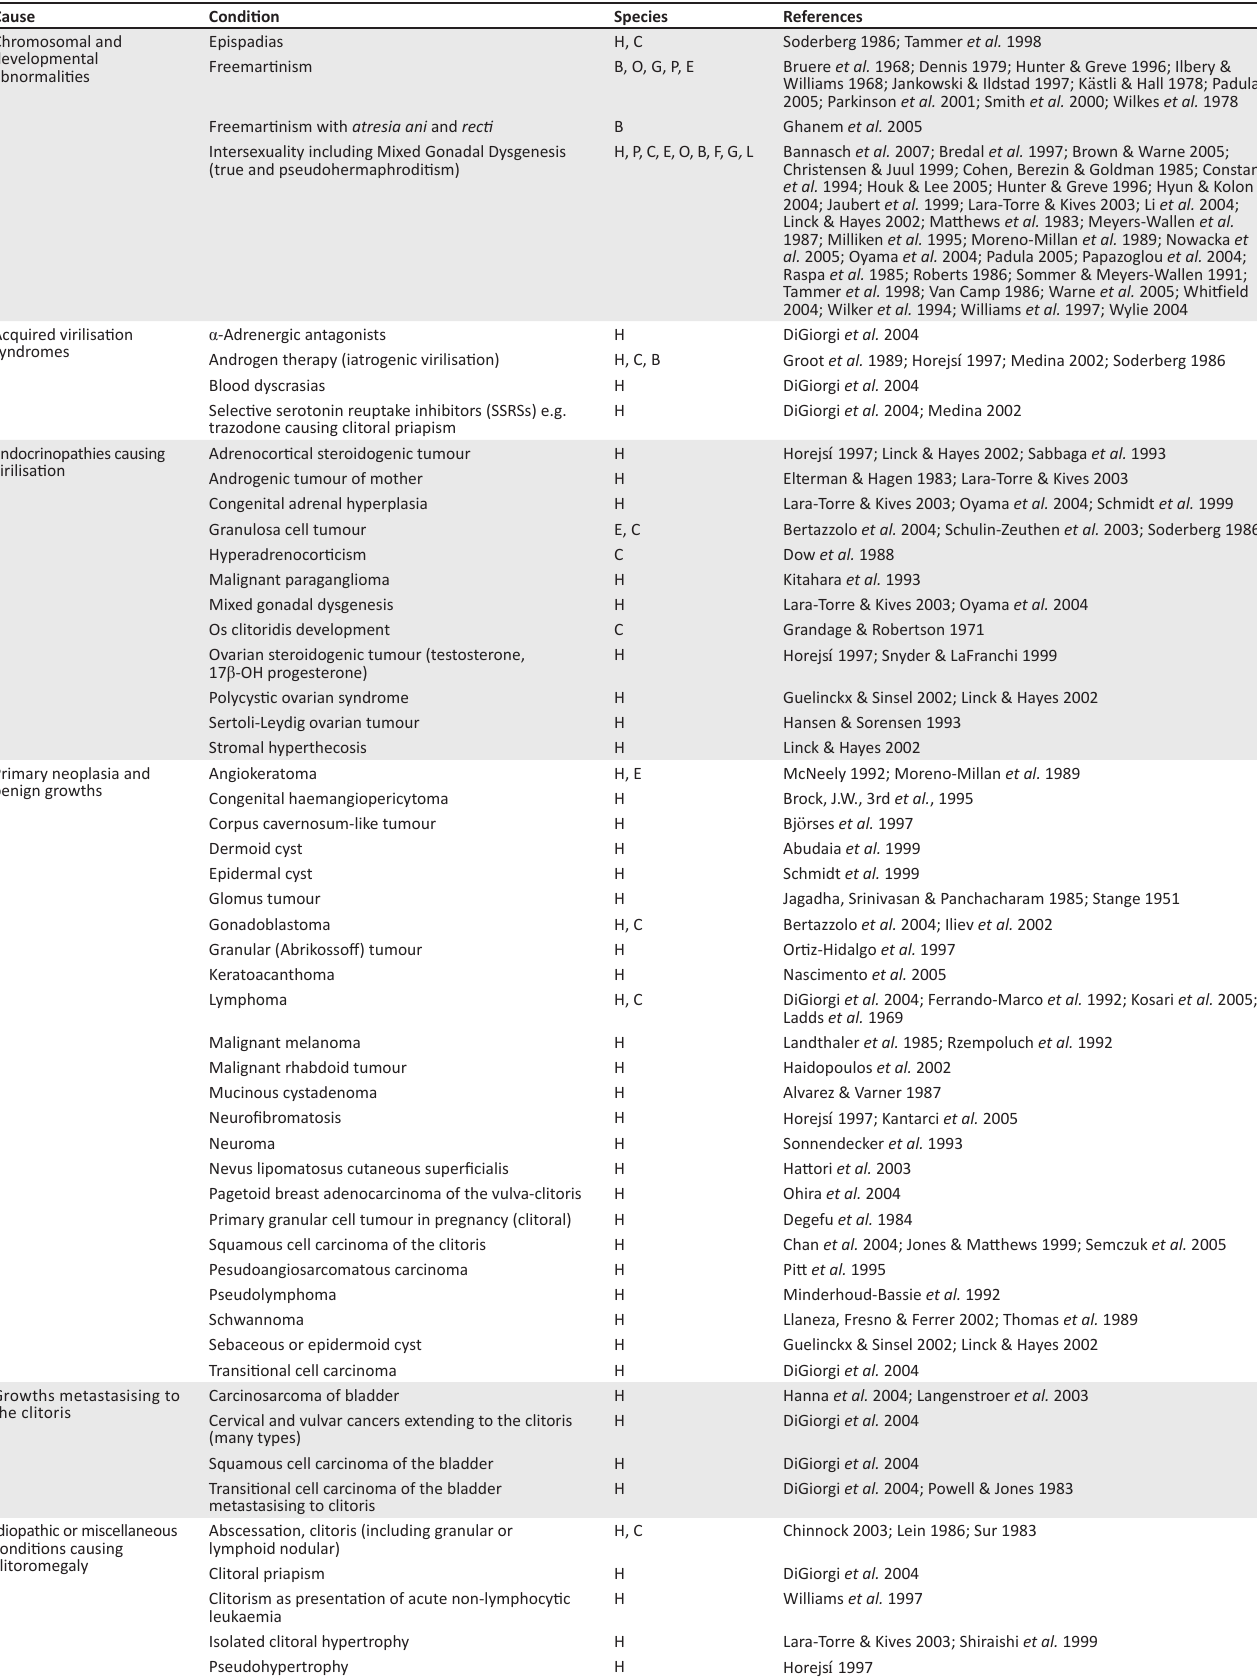
TABLE 3: Reported causes of clitoromegaly in the veterinary and medical literature.